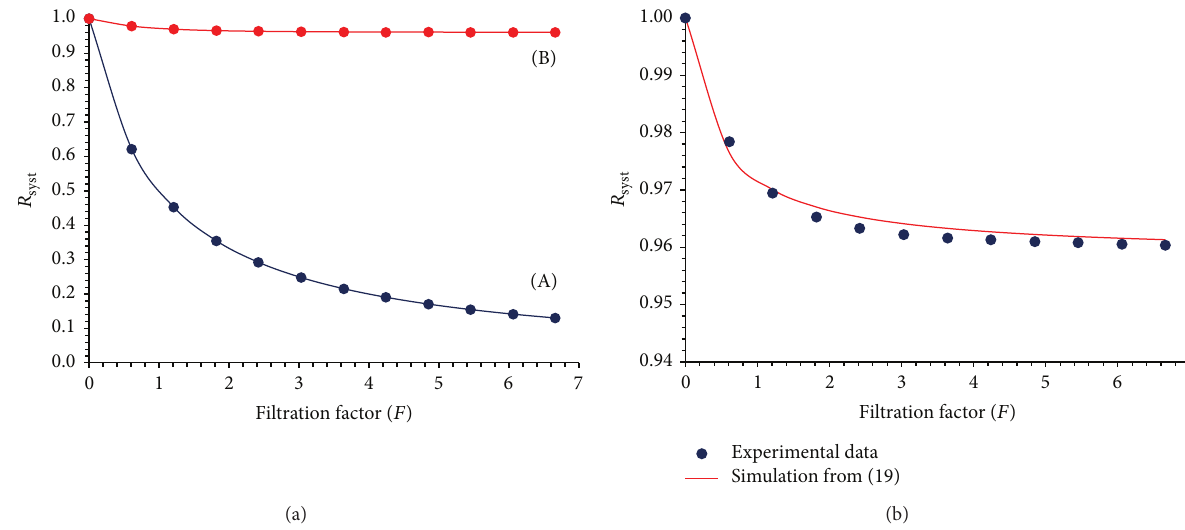
Figure 4: (a) Retention profiles for PSSNA-Cd and blank experiment (A and B, resp.) and (b) semiempirical modeling of retention profile from experimental data by (19).